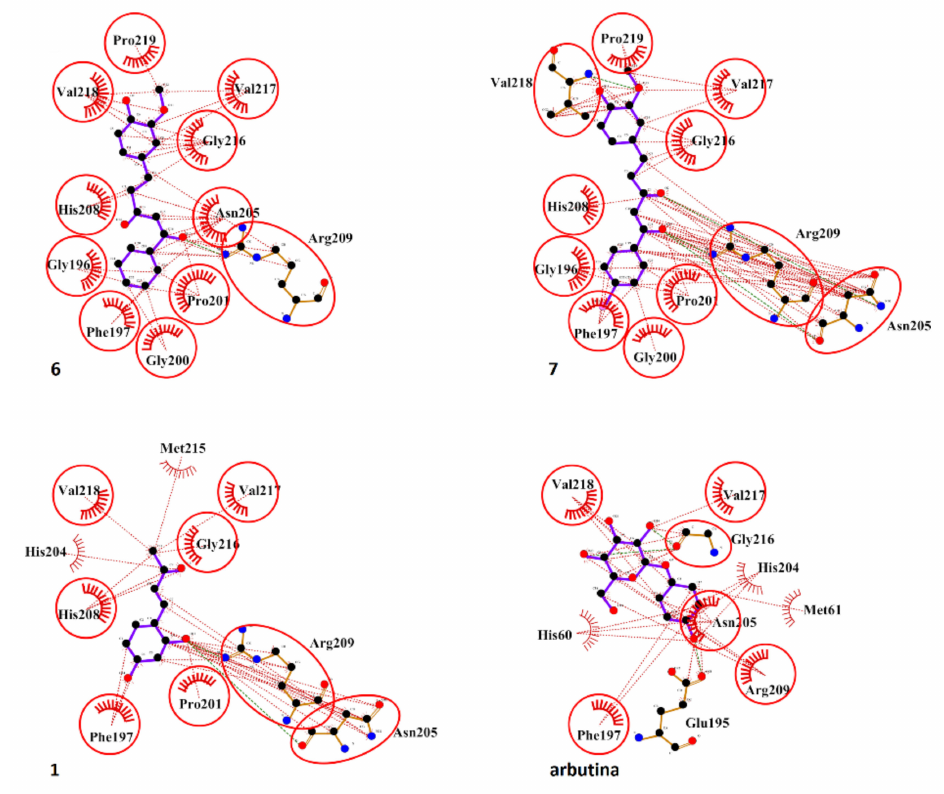
Figure 10. Hydrophobic interactions of the lowest docking poses of compounds 6 , 7 , 1 and arbutin with the catalytic site of B. megaterium tyrosinase (3NM8) performed with LigPlot+